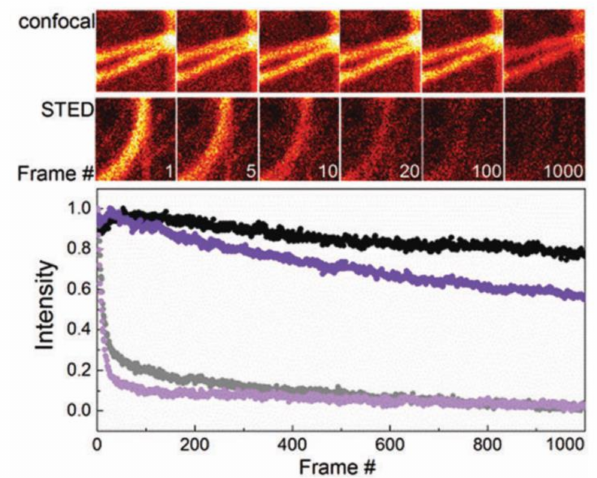
Figure 2. Top: Consecutive live cell fluorescence images of microtubules in COS-7 cells labeled with mGarnet2 using confocal microscopy and STED nanoscopy. Bottom: Normalized fluorescence intensity of the images as a function of the frame number upon confocal (black, violet) and STED (grey, light violet) imaging of live COS7 cells labeled with mGarnet (black, grey), and mGarnet2 (violet, light violet). Pixel dwell time: 40 µ s. Excitation laser wavelength: 640 nm, Excitation laser power: 12.5 µ W, STED laser wavelength: 780 nm, STED laser power: 36 mW. (Reproduced from Ref. [31] with permission from the Royal Society of